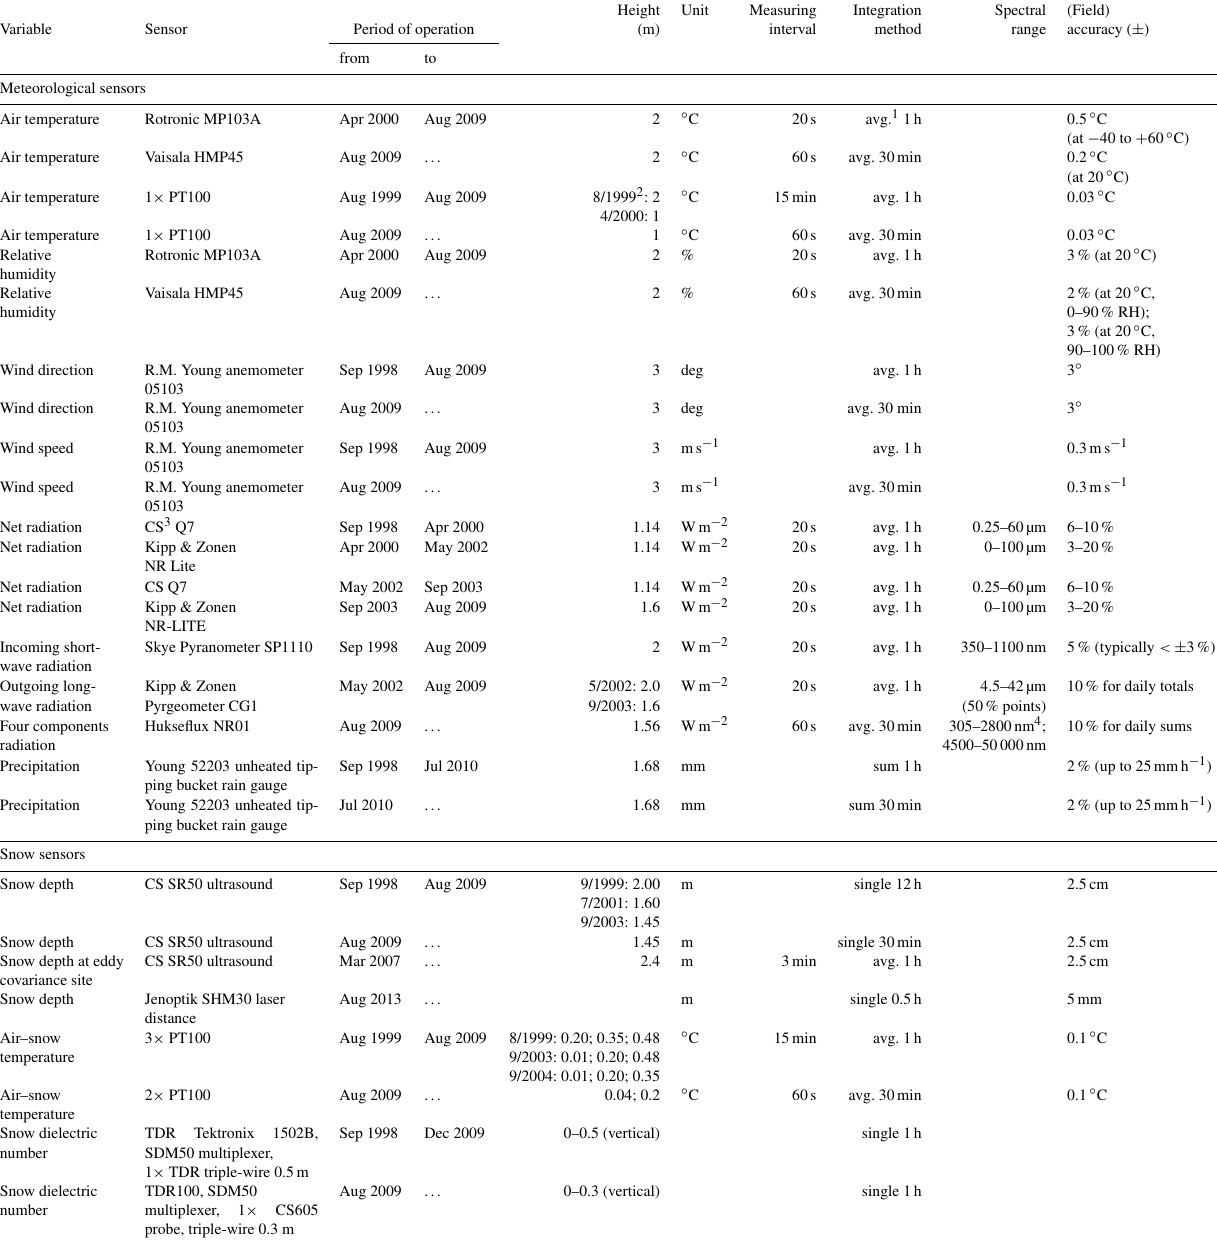
Table 2. List of sensors, parameters and instrument characteristics for the automated time series data from the Bayelva site, 1998–2017. Additional (not automated) data on snow cover and soil profiles can be found in Appendices E and F. Positive heights are above surface; negative heights are below